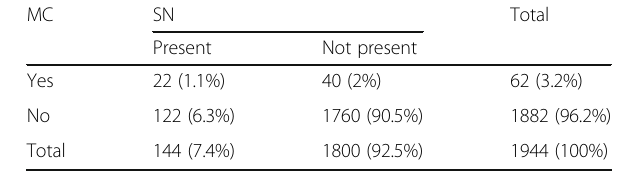
Table 6 Significant relation between MC and